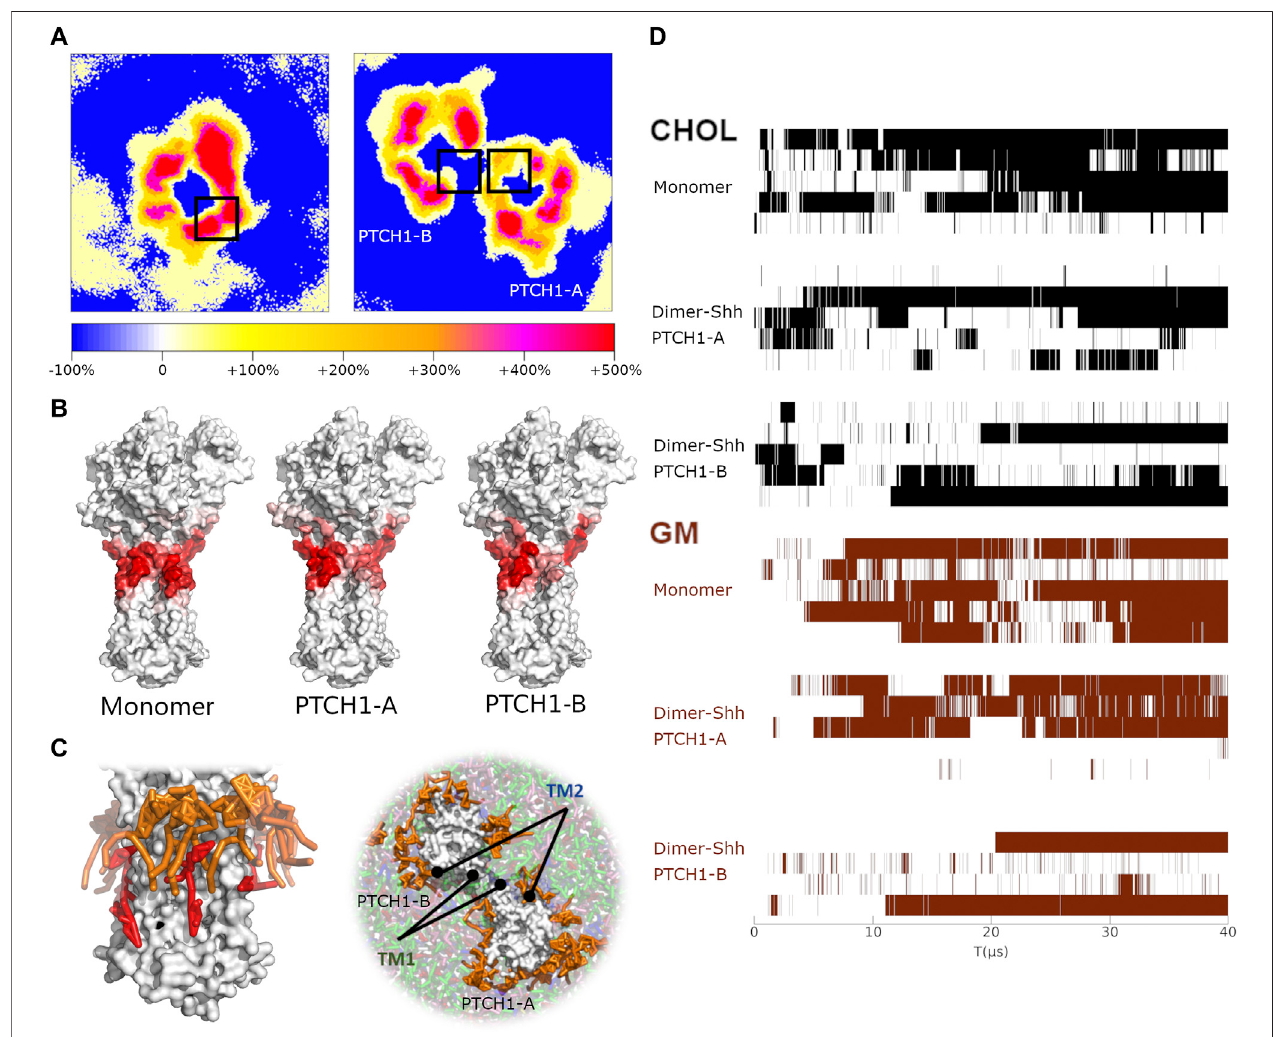
FIGURE 4 | The correlation of GM clusters and CHOL binding. (A) 2D density maps of GM for the PTCH1 monomer and dimer-Shh systems, calculated by averagingthelast10 μ ssimulations.TheblackboxesidentifythelocationofSSDs. (B) ThehotspotsmapsoftheGM-PTCH1interactionsinthemonomeranddimer-Shh (PTCH1-A and PTCH1-B) systems. (C) Snapshots of the monomer and dimer-Shh systems. GMs are colored in orange, and CHOL in red. (D) Variations of the CHOL binding to the SSD and the GM interacting with the SSD over the simulation time. For the CHOL binding, when the distance of P504-ROH is less than 1 nm, it is marked in black. For the GM interactions, when the residues of TM1 and TM2 have interactions simultaneously with GMs (minimum distance less than 0.65 nm), it is marked in brown.